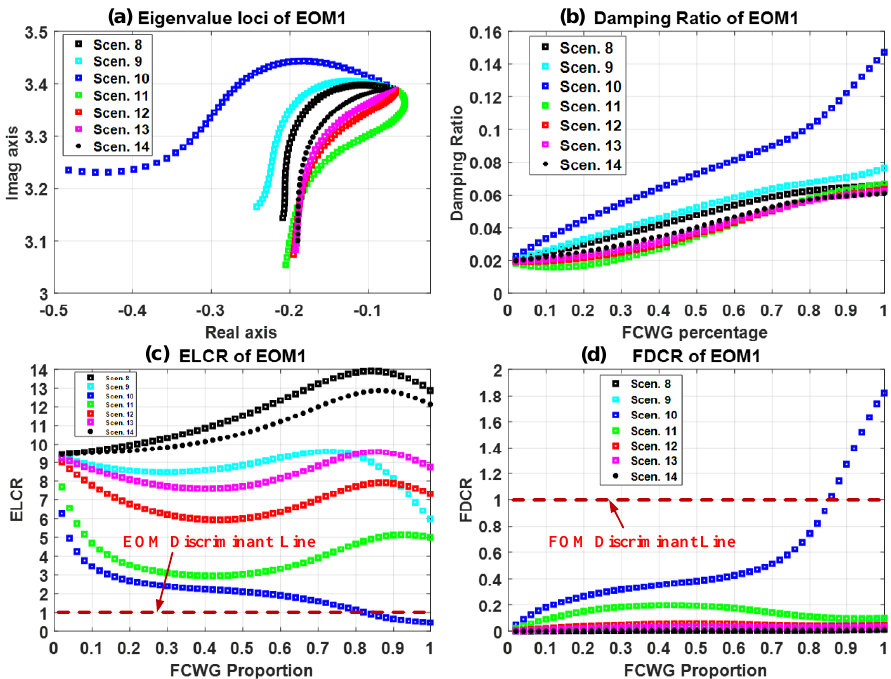
Figure 10. The interaction between DC-FOM and EOM1, considering increasing FCWG proportion: ( a ) eigenvalue loci; ( b ) variation trend of damping ratio; ( c ) variation trend of ELCR; ( d ) variation trend of FDCR.